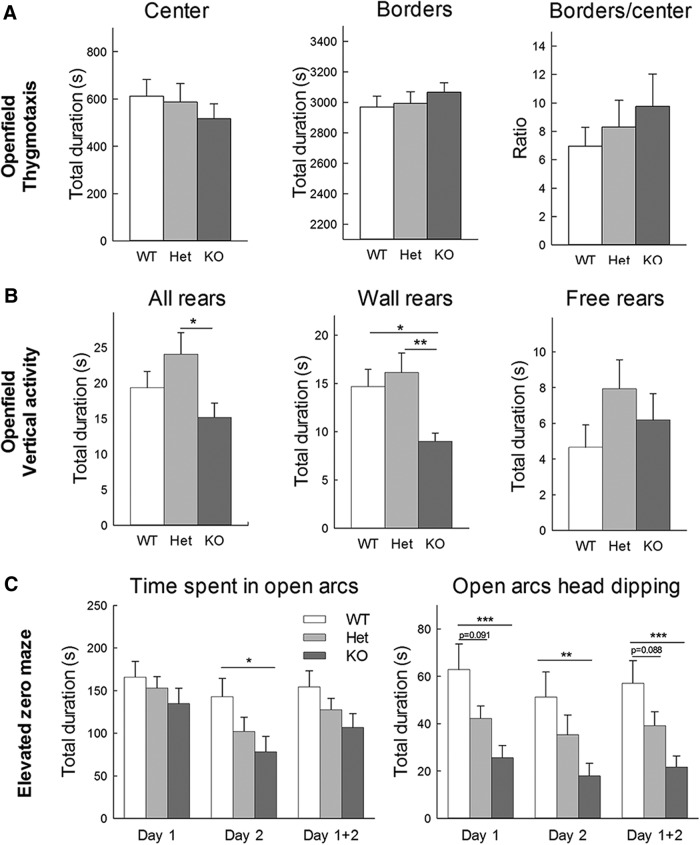
Anxiety-like behavior in Shank3Δ4-22-deficient mice. A, Thigmotaxic behavior in open field. No genotype differences were found for the time spent in the center of the open field, the time spent close to the chamber walls (borders), or their ratio. B, Vertical activity in open field. The cumulated time spend in free standing rears and rears against the walls of the open field were both counted. When compared to wild-type and heterozygotes littermates, Shank3Δ4-22 homozygous mice displayed decreased rearing activity due to a decrease of wall rears rather than free standing rears. C, Shank3Δ4-22 homozygous mice spent a lower amount of time in the open area when compared to wild-type and heterozygous mice. Similarly, the number of head dipping from the open arcs to the outside of the maze was reduced in Shank3Δ4-22 homozygous mice. WT, wild-type mice; Het, heterozygous mice; KO, homozygous knock-out mice. *p < 0.05, **p < 0.1, ***p < 0.001.